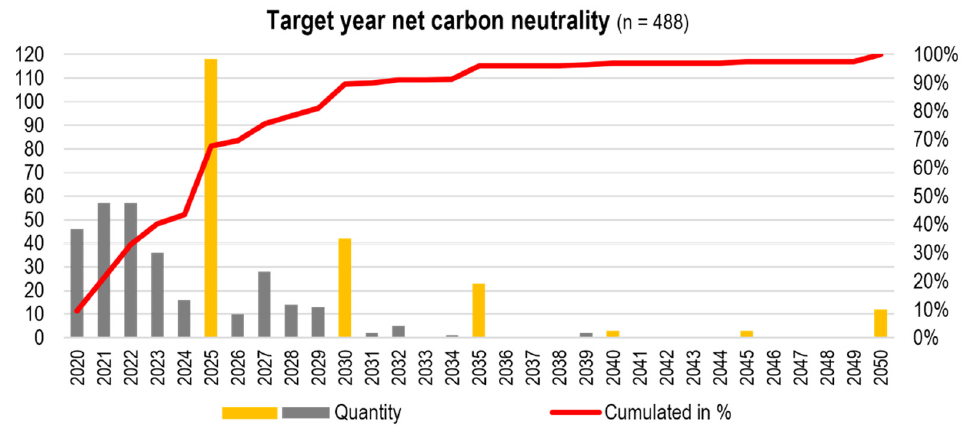
Figure 3. By when do companies plan to reach net carbon neutrality [38,39]?